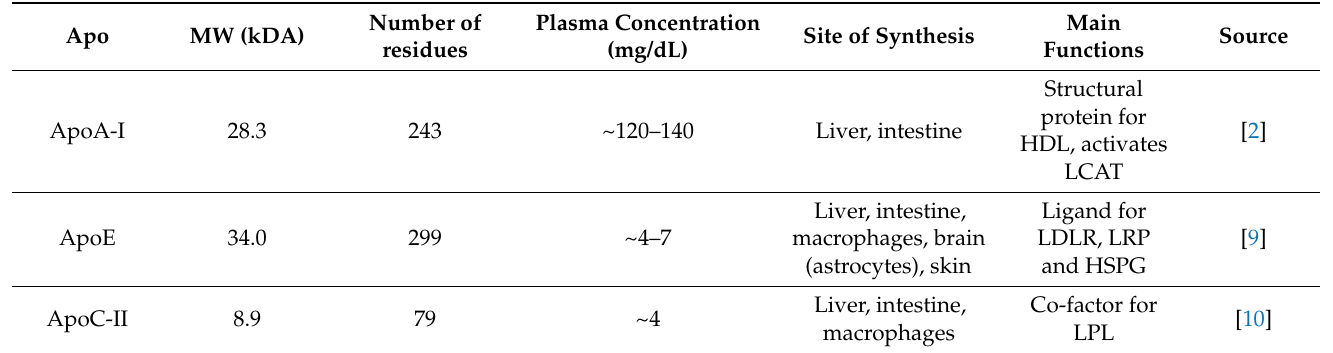
Table 1. Characteristics of apoA-I, apoE and